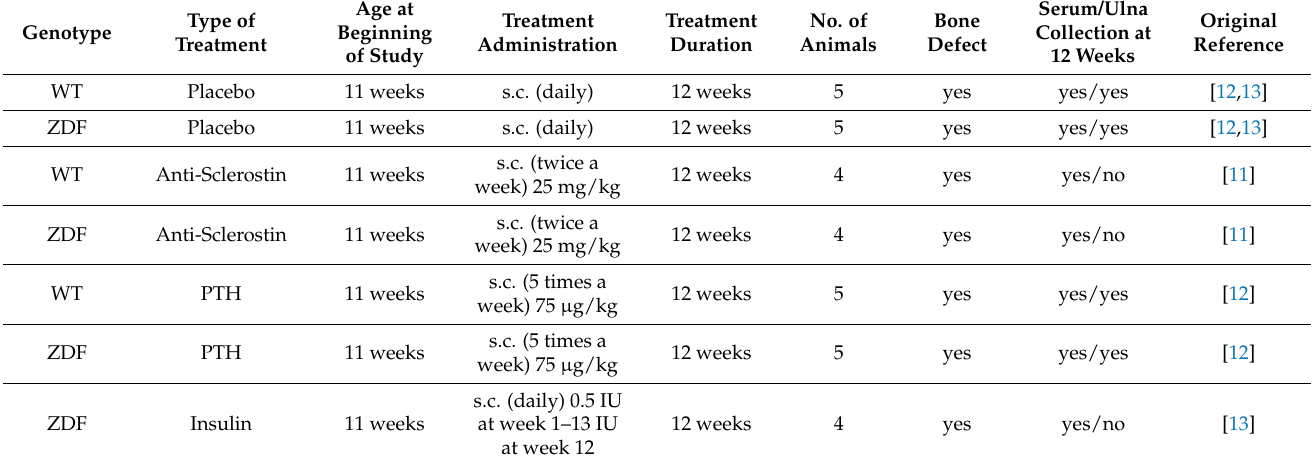
Table 1. Summary of the animals used for the study and the experimental design of the ZDF study [11–13]. In total, 18 ZDF rats and 5 wild-type rats, at the age of 11 weeks, underwent femur subcritical defect surgery. After 24 h, ZDF rats were randomized into a placebo treatment with vehicle solution (placebo, n = 5), PTH treatment (PTH, n = 5), insulin treatment ( n = 4), or anti-sclerostin treatment (anti-scl, n = 5) for 12 weeks. Micro-CT, serum, and tissue analyses were performed as indicated in the Materials and Methods